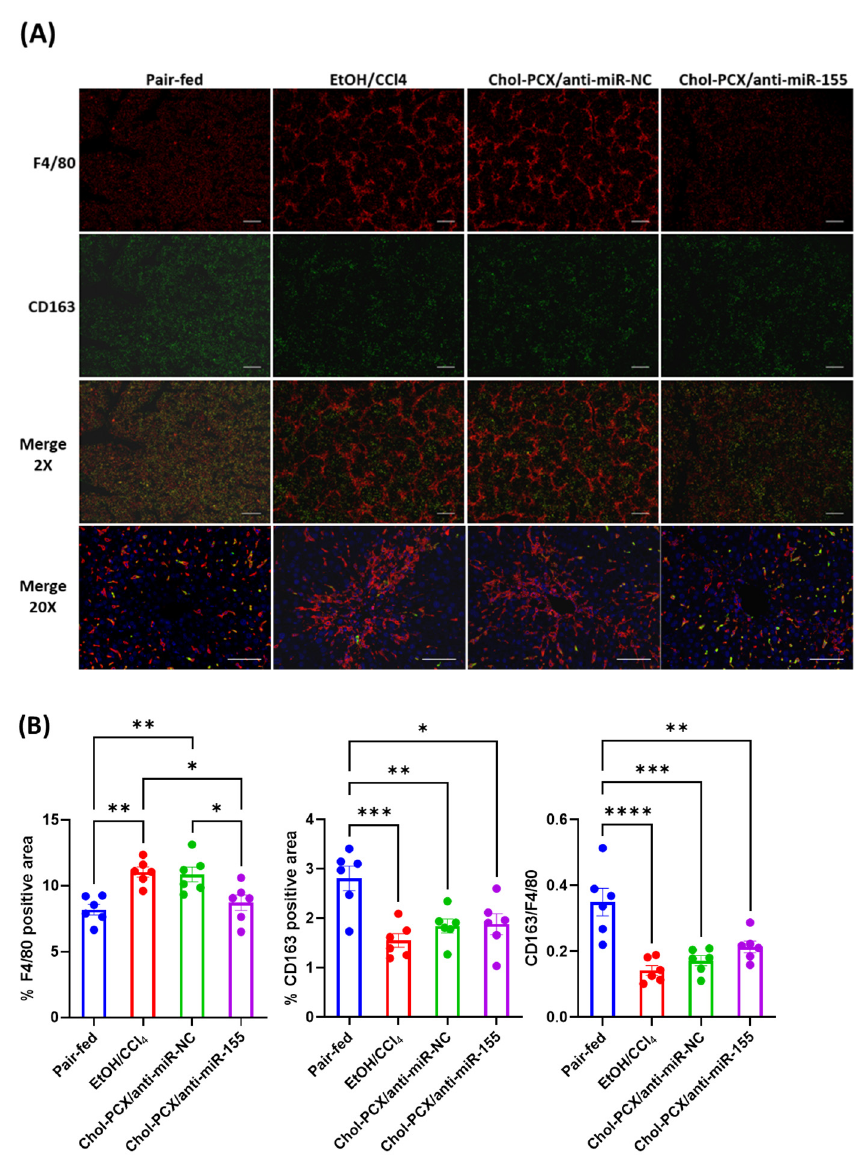
Figure 13. Immunohistochemistry for F4/80 (total macrophage or KCs stain) and CD163 (M2 phenotype). ( A ) Red fluorescence representing F4/80 and green fluorescence representing CD163. Scale bar: 2× (400 μ m), 20× (200 μ m). ( B ) Total macrophage content and CD163 + M2 macrophage quantification from the confocal images. Data were analyzed by one-way ANOVA followed by Tukey’s comparison test. Data are expressed as mean ± SEM ( n = 6). * p < 0.05, ** p < 0.01, *** p < 0.001, and **** p < 0.0001.